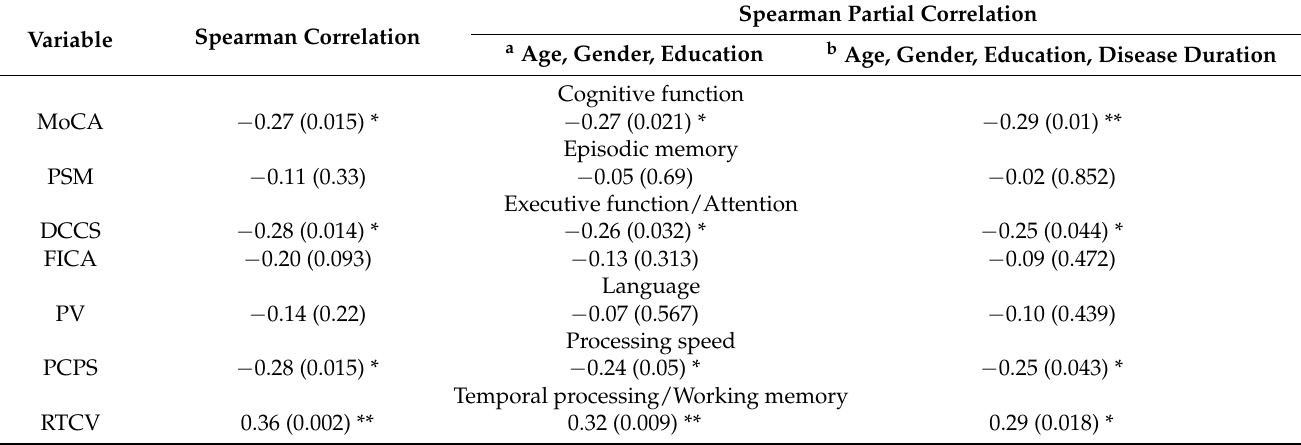
Table 3. Correlations between FOG scores and cognitive